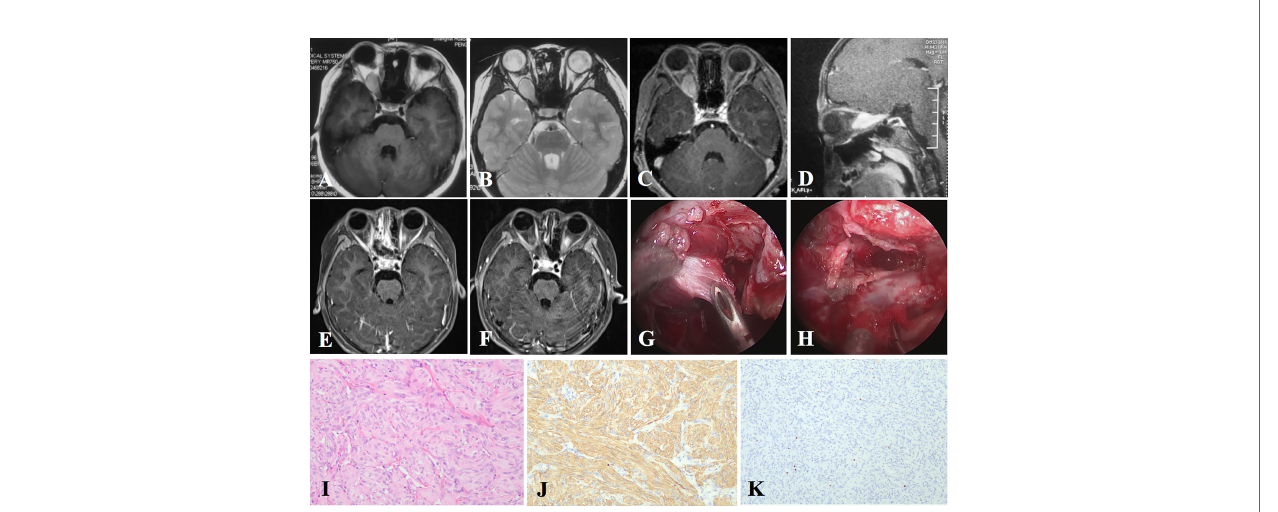
FIGURE 2 | The radiological images, intraoperative pictures, and pathological staining of Case 1. (A – D) Preoperative MRI indicates an intraconal lesion with both medial and lateral extension to the optic nerve. (E) Postoperative MRI shows total resection of the tumor. (F) Six-month follow-up MRI shows no recurrence. (G) Intraoperatively, the intraconal tumor is found to be tenacious. (H) The tumor is totally resected. (I) Hematoxylin – eosin (H&E) staining shows the optic nerve completely replaced by neoplastic spindle cells with a nested pattern in microscope (original magni fi cation ×200). (J) Tumor cells are positive for glial fi brillary acidic protein (GFAP) in immunochemistry (original magni fi cation ×200). (K) Ki-67 index is relatively low (original magni fi cation